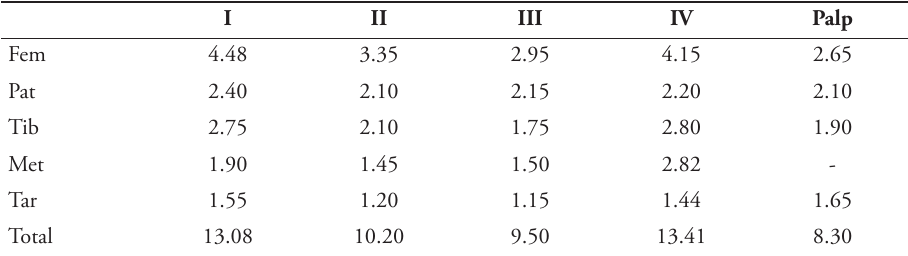
Table 3. Legs and palp measurements (in millimeters) of paratype CUMZ-C4-NA4 ♀ Phlogiellus longi- palpus sp. n. from Thailand. RF =